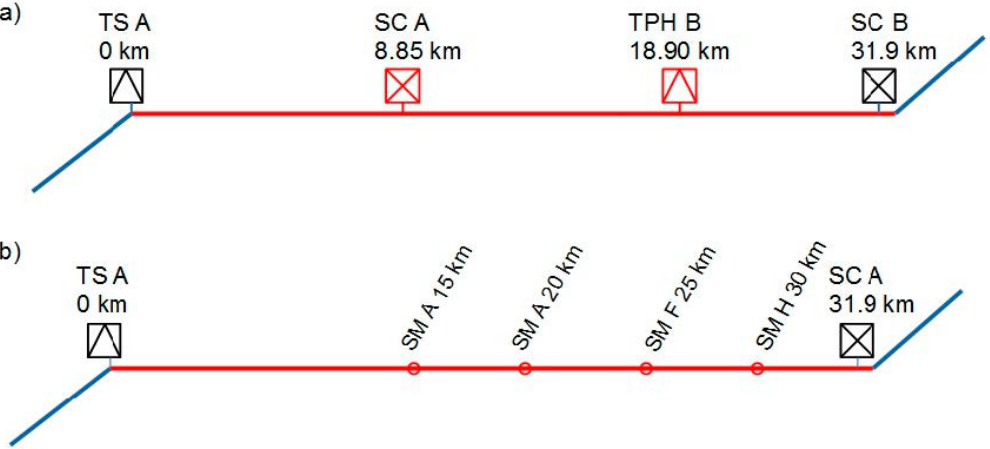
Figure 4. The scheme of the traction power infrastructure analyzed in the case